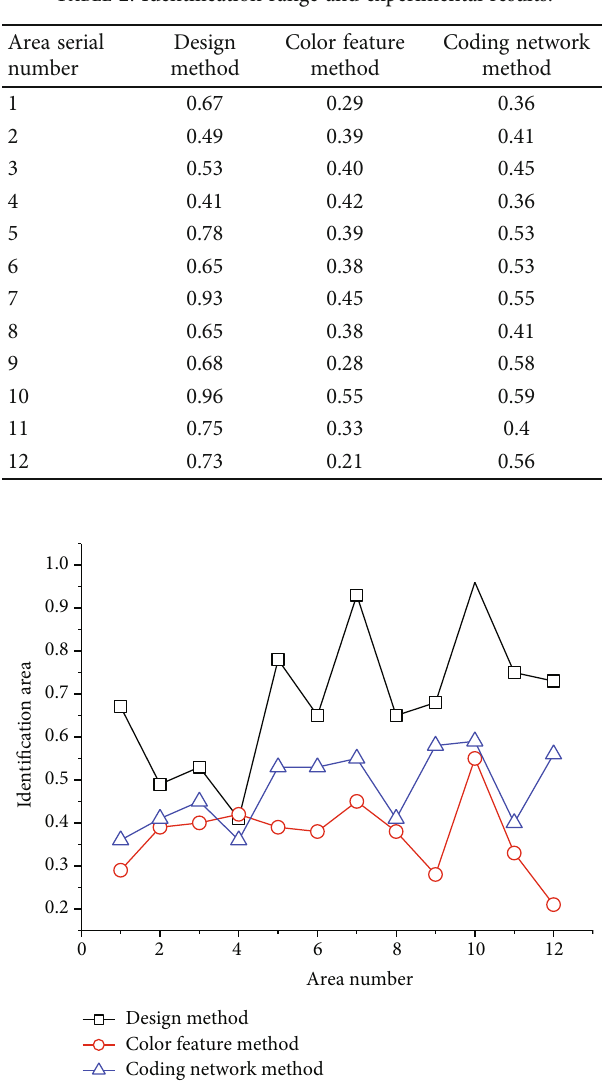
Table 1: Recognition rate experimental results.